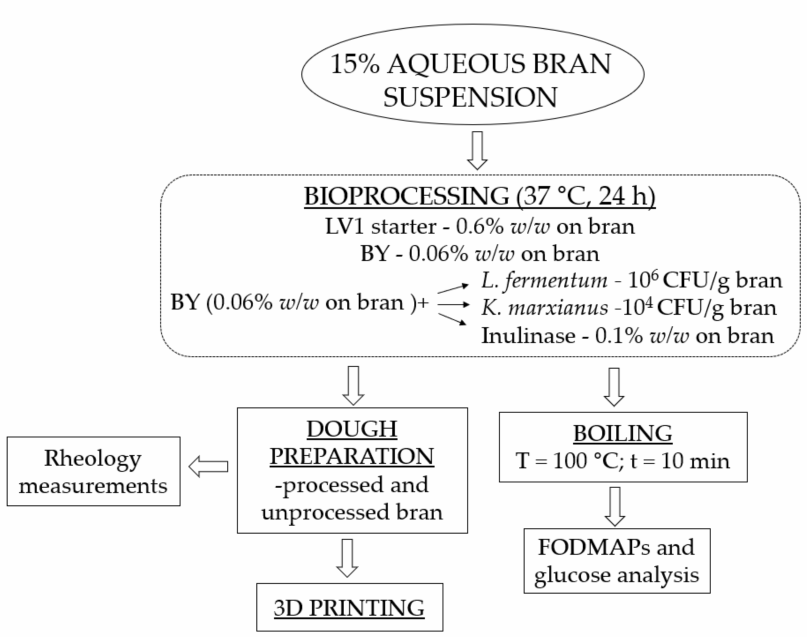
Figure 1. Schematic representation of bran bioprocessing and its use in dough preparation. BY, bakery